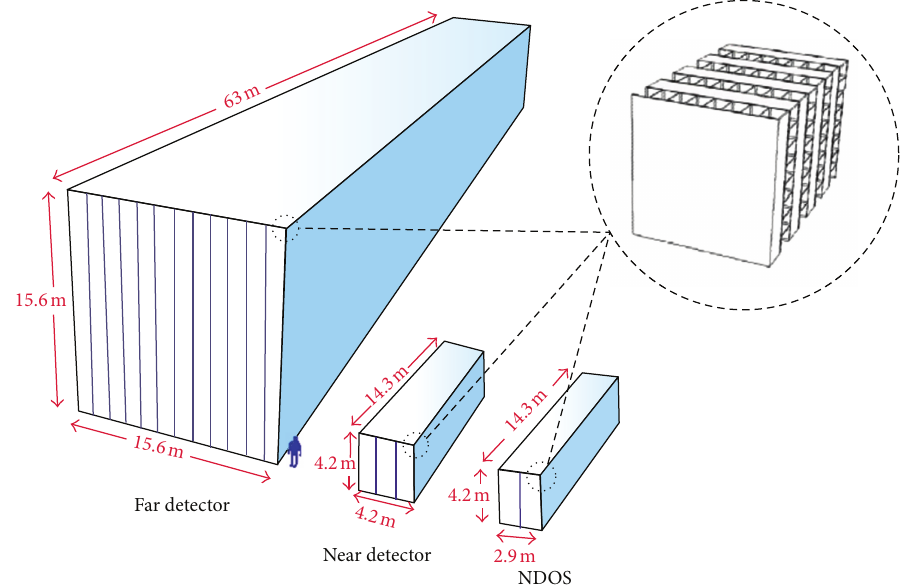
Figure 11: Drawings of the NO 𝜈 A Far and Near detectors. The human figure at the base of the Far detector is for scale.